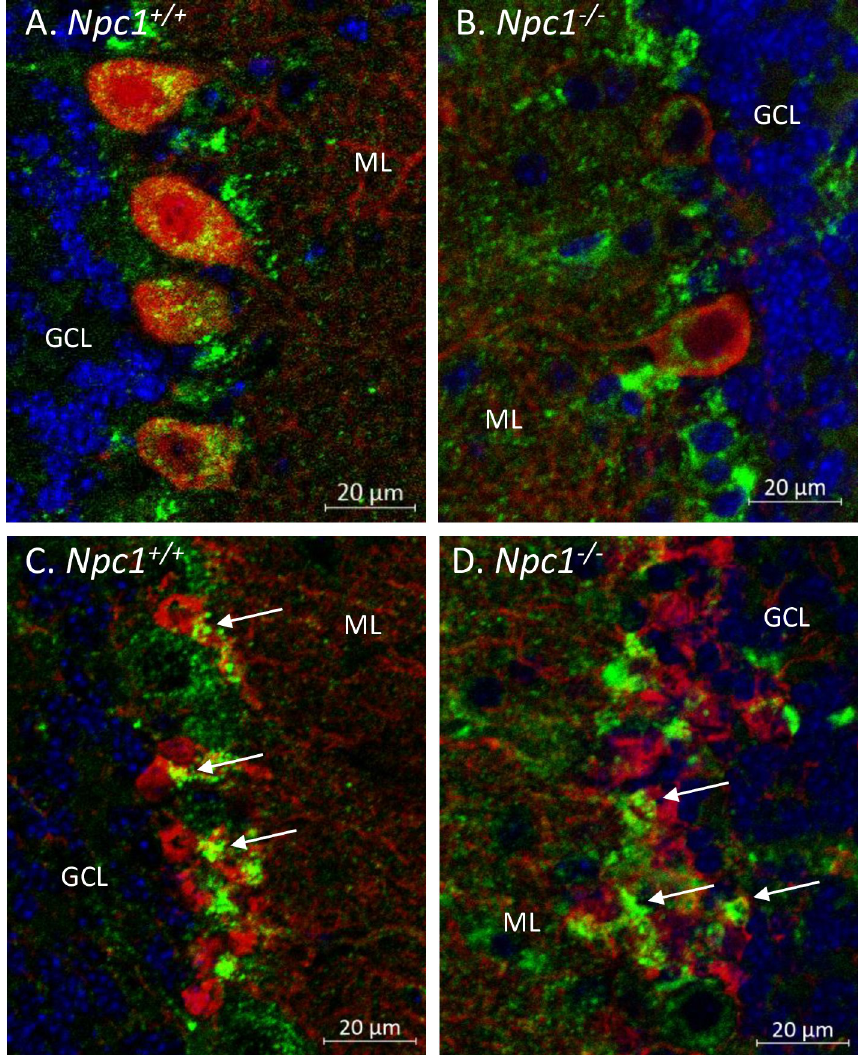
Fig 4. Confocal immunofluorescence microscopy of 7-week-old Npc1 +/+ and Npc1 -/- lobule I cerebellum. ( A ) LAMP1 staining (green) is present in the soma of Purkinje neurons (red) and other cells in the Purkinje cell layer of Npc1 +/+ cerebellum. ( B ) There is a dramatic loss of Purkinje neurons in Npc1 -/- cerebellum at this age and a general increase in LAMP1 staining. ( C ) Other LAMP1 positive cells were identified as Bergmann glia by their localization and co-staining with S100 β (arrows). ( D ) Increased S100 β staining is observed in Npc1 -/- consistent with an increase in astrogliosis. Sections were counterstained with Hoechst 3342 (blue), distinguishing the granule cell layer (GCL) from the molecular layer